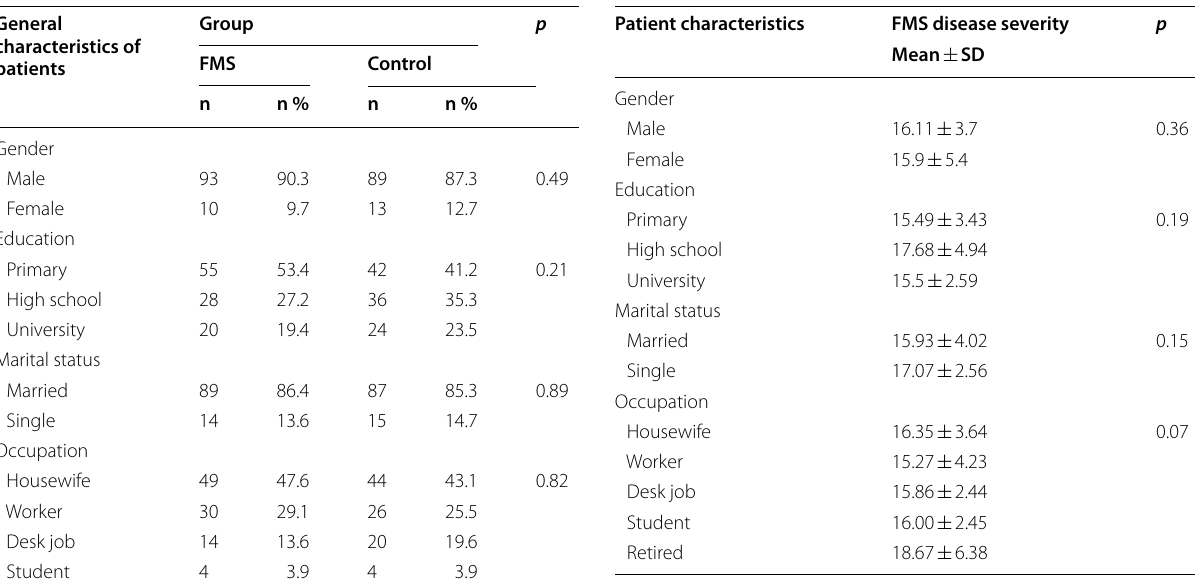
Table 4 Analysis of general characteristics of patients according to groups